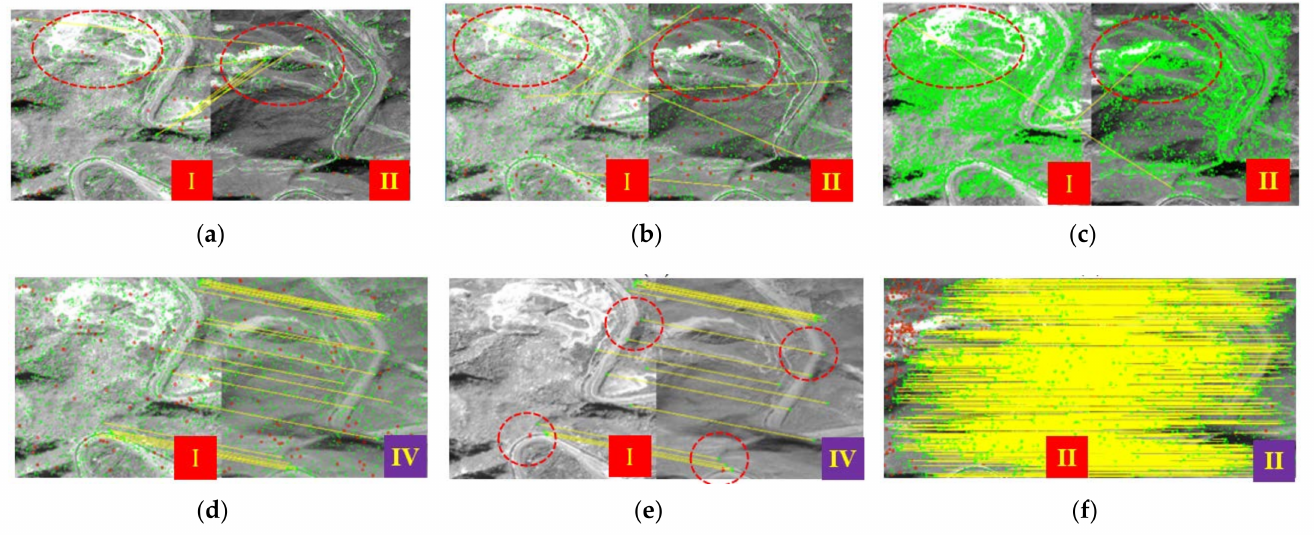
Figure 13. Feature extraction and matching results of local original image (780 × 800 pixels) and stable feature image of mine treatment area. The feature algorithms used are ( a ) SURF, ( b ) SIFT, ( c ) ORB, and ( d – f ) SIFT. ( e ) Filtering the inner points again by MOF. The roman numeral in the lower right corner is the image number, which corresponds to the image with the same number and background color in Figure